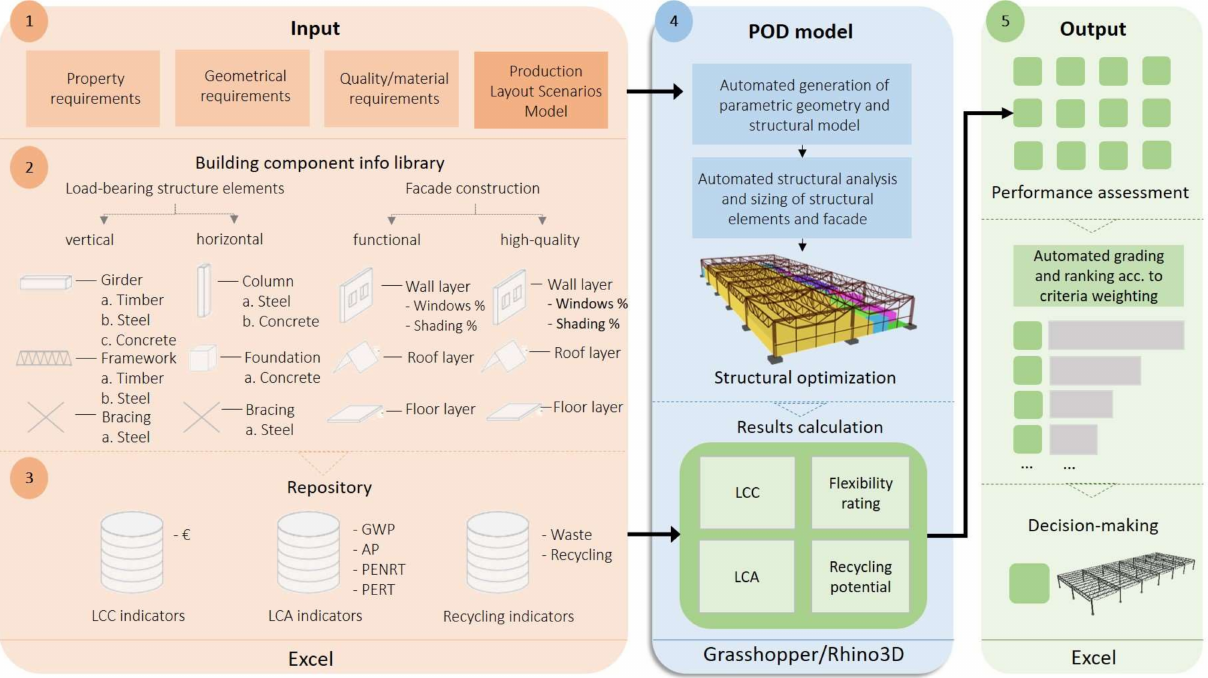
Figure 2. The POD model